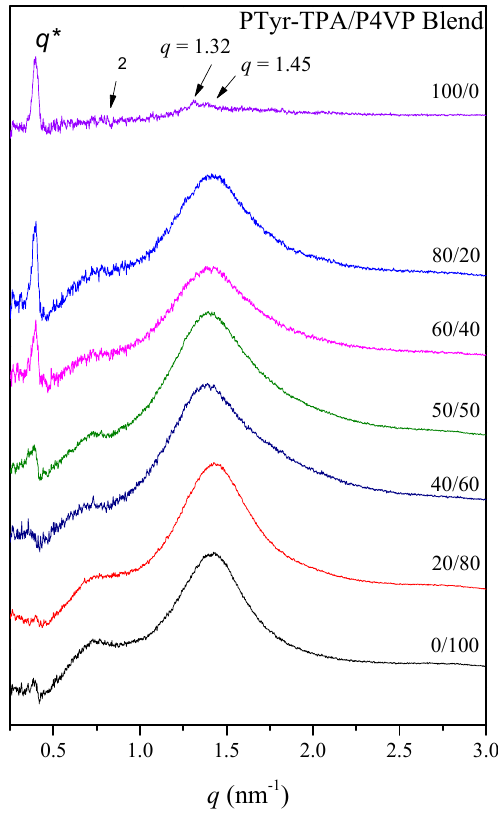
Figure 12. WAXD analyses of the miscible PTyr-TPA/P4VP blends.